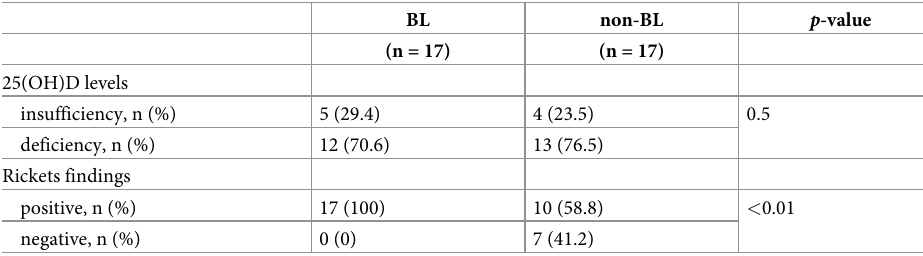
Table 2. The ratios of vitamin D deficiency/insufficiency and rickets findings on X-rays. BL non-BL